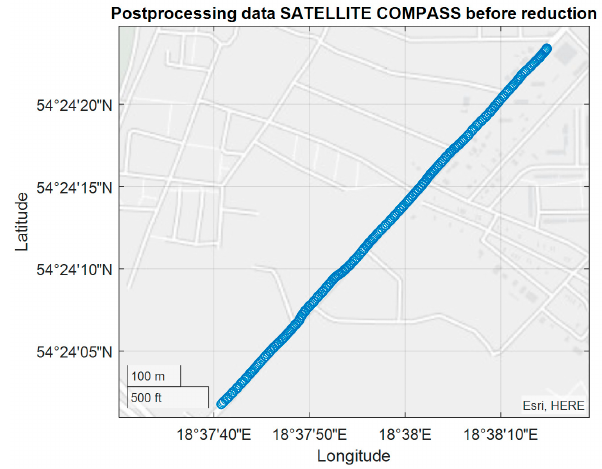
Figure 21. Position registration of the tram from 00:25:17 UTC to 00:30:37 UTC.